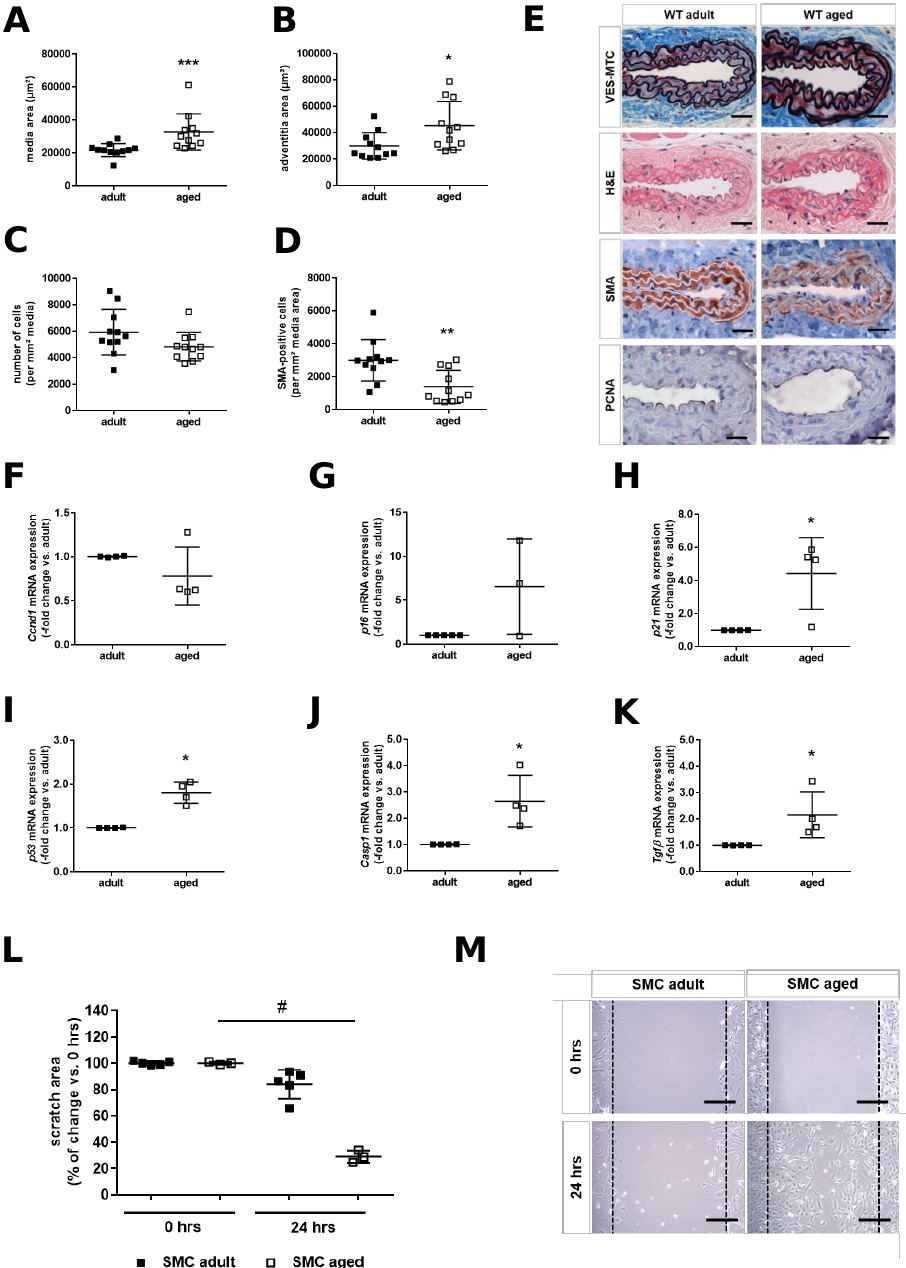
Figure 1. Age-associated changes of the arterial vessel wall. Cross-sections through the uninjured common carotid artery of adult ( n = 11) and middle-aged ( n = 11) mice were stained with VES-MTC to visualize elastic fibers (black), muscle cells (red) and extracellular matrix (blue), or with H&E to visualize cell nuclei (blue-black). Antibodies against smooth muscle alpha-actin (SMA) or proliferating cell nuclear antigen (PCNA) were used to immunostain smooth muscle cells (red) or proliferating cells (brown), respectively. The media area ( A ) and adventitia area ( B ) were quantified using ImagePro Plus analysis software. The total number of cells was counted manually and expressed per mm 2 media area ( C ). The SMA-immunopositive area per total media area was determined using the count-size function ( D ). Individual data points and the mean ± SD are shown. * p < 0.05, ** p < 0.01 and *** p < 0.001 vs. adult mice (as determined by Student’s t -test for unpaired means (in B) or the Mann–Whitney test